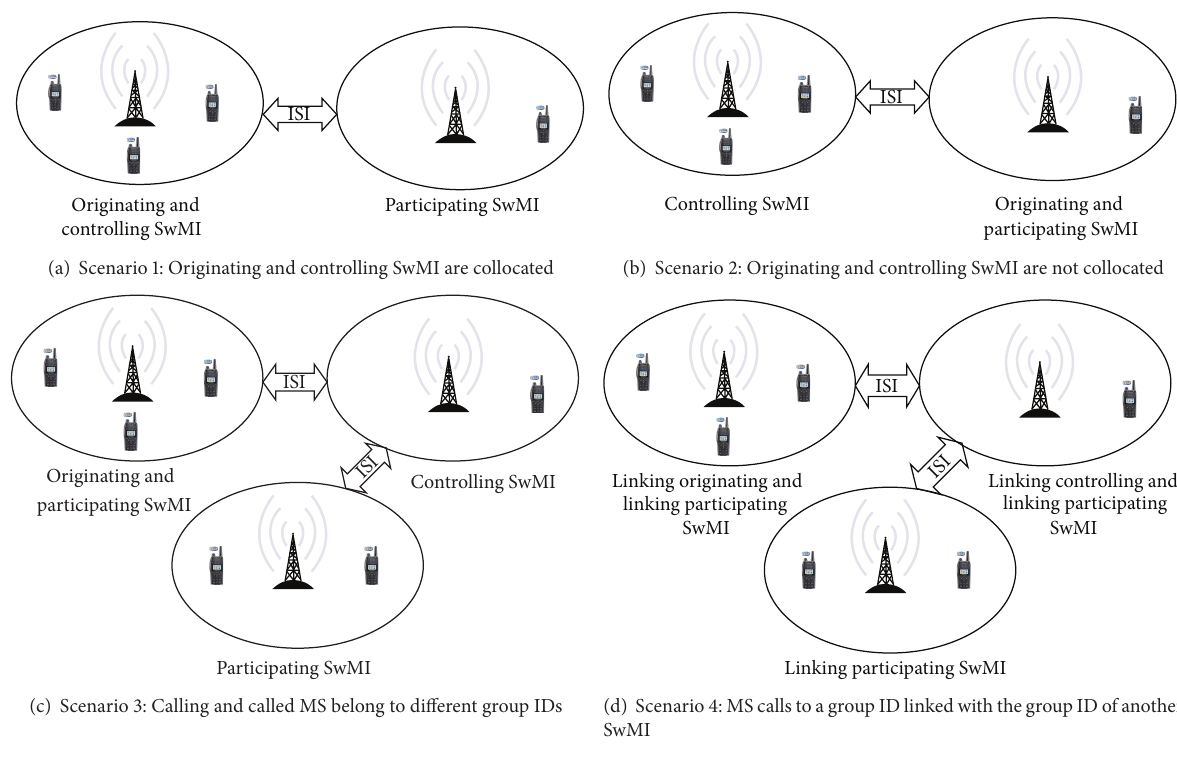
Figure 5: Group call scenarios